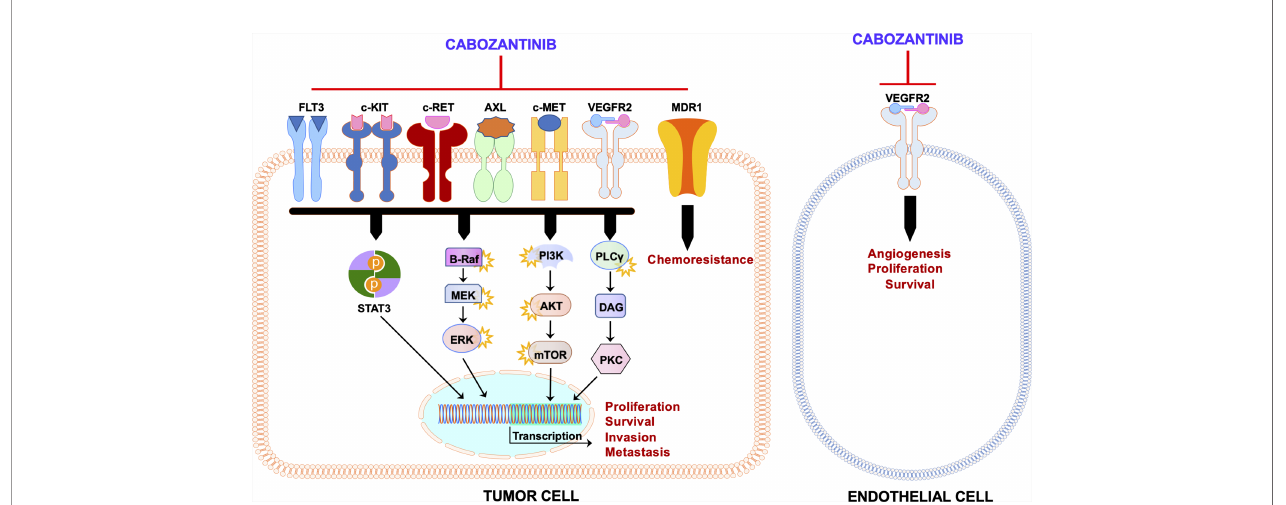
FIGURE 2 | Schematic representation of the mechanism of action of cabozantinib. Administration of cabozantinib to cancer cells leads to the inhibition of several tyrosine kinases (c-MET, VEGFR2, AXL, c-KIT, c-RET, and FLT3) as well as MDR1/P-glycoprotein in the tumor cell and/or in the endothelial cell. These tyrosine kinases, once activated, induce a plethora of downstream pathways (STAT3, Ras/BRAF/MEK/ERK, AKT/mTOR, PLC g /PKC, etc.) that lead to several biologic effects on the cells (proliferation, survival, migration, chemoresistance, etc.). These activities are blunted by cabozantinib. Black arrows indicate activation, whereas red blunted arrows indicate